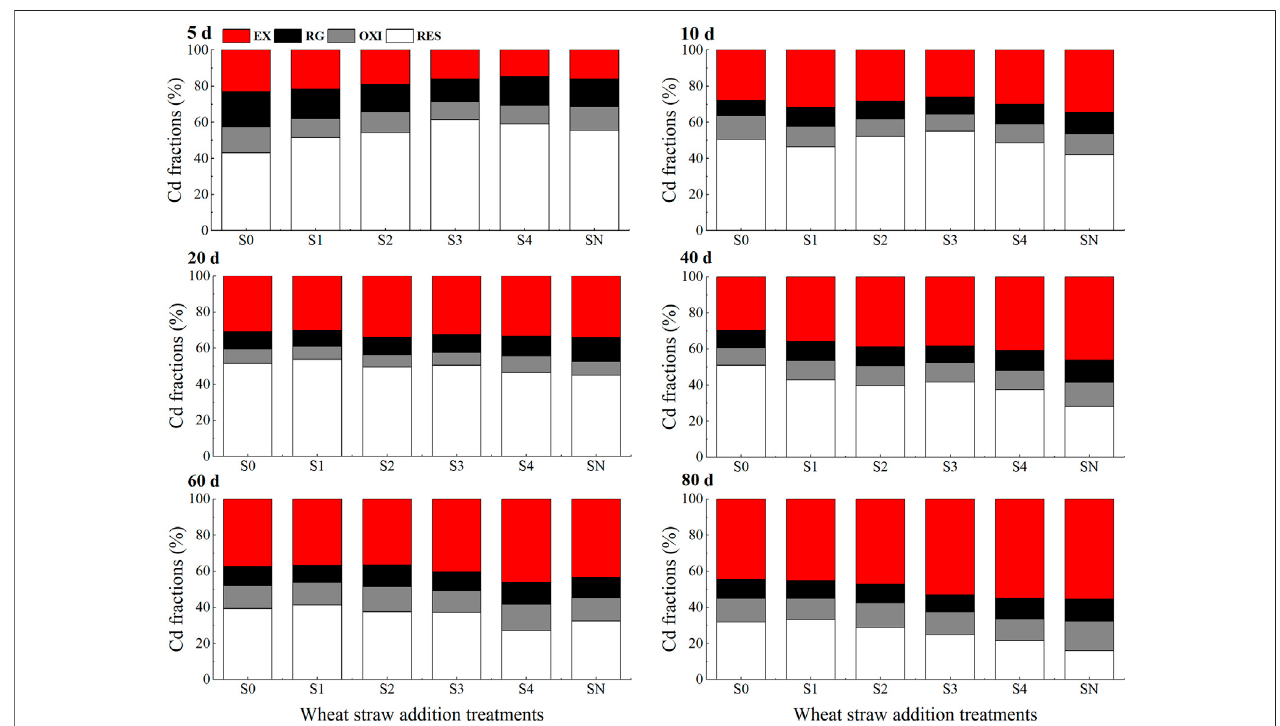
FIGURE 4 | Effect of wheat straw addition on geochemical fractions of Cd in remaining soil. EX, exchangeable fraction; RG, reducible fraction; OXI, oxidizable fraction; RES, residual fraction.